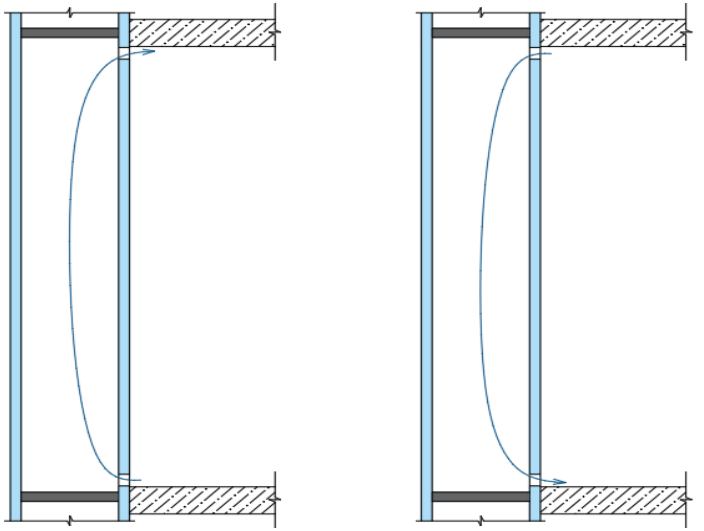
Figure 9. Facade systems with ventilation of the interstitial space with internal air (internal air curtain).